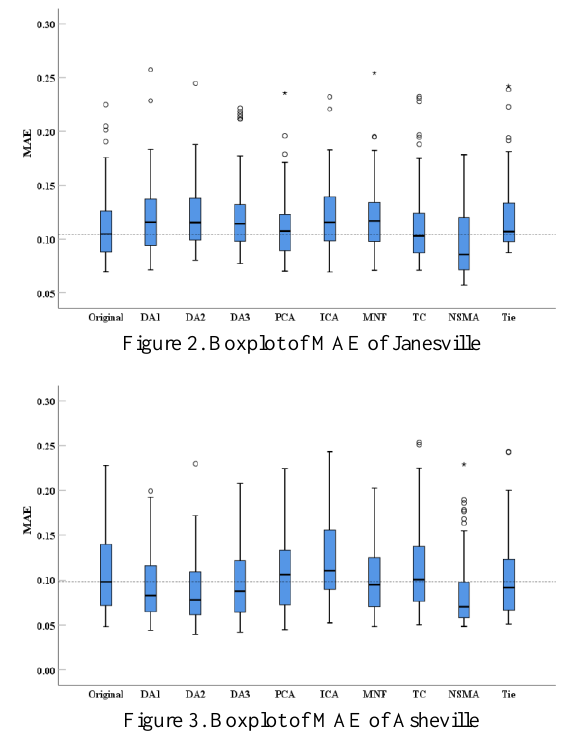
Figure 3. Boxplot of MAE of Asheville